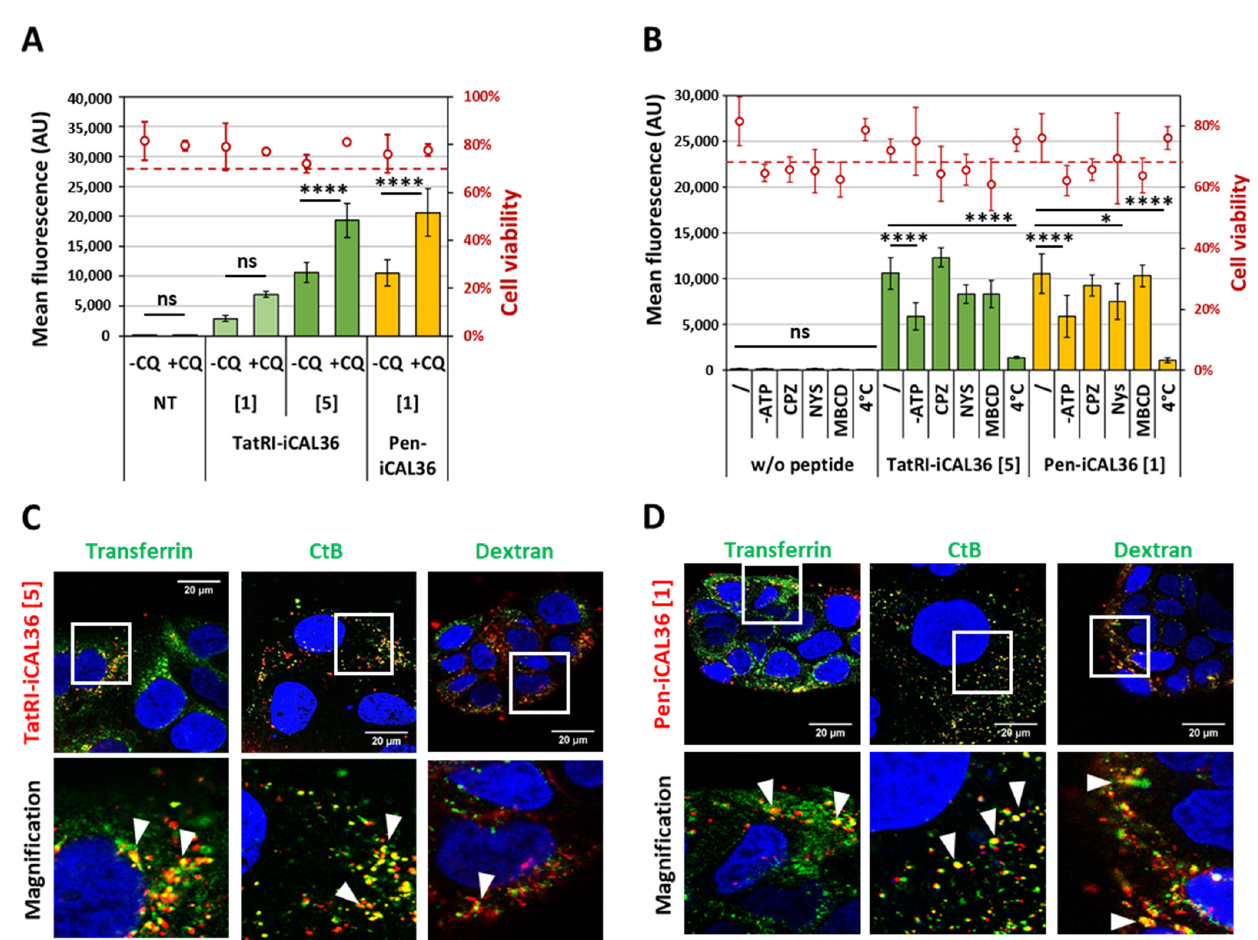
Figure 3. Dissecting the internalization mechanism of TatRI-iCAL36 and Pen-iCAL36. ( A ) Caco-2 cells were incubated with Tamra-TatRI-iCAL36 (1 μ M = [1] or 5 μ M) = [5] and Tamra-Pen-iCAL36 (1 μ M = [1]) and compared to non-treated cells (NT) in the absence or presence of chloroquine (CQ, 100 μ M). After cell trypsinization (to remove external peptides), the fluorescence and cell viability were assessed via flow cytometry. Graphical representation of data obtained from four independent measurements (mean ± SD, n = 4). A statistically significant difference was noticed between the incubation conditions without and with CQ for TatRI-iCAL36 and Pen-iCAL36 at 5 μ M, whereas no statistical difference was revealed for TatRI-iCAL36 at 1 μ M (one-way ANOVA with Bonferroni test, statistical relevance given as **** p < 0.0001 and ns > 0.05). ( B ) Caco-2 cells were incubated with Tamra-TatRI-iCAL36 (5 μ M) and Tamra-Pen-iCAL36 (1 μ M) at 4 °C or in the presence of either ATP- depleting reagents (NaN 3 /DG) or endocytosis inhibitors (CPZ, NYS or MBCD) at 37 °C. The same conditions were used on cells without peptides (w/o peptide) to determine the effect of the endocytosis inhibition. For all conditions, fluorescence and cell viability were acquired via flow cytometry after cell trypsinization (to remove membrane externally bound peptides). Graphical representation of data obtained from four independent measurements (mean ± SD, n = 4). A statistically significant difference compared to untreated condition was noticed for ATP depletion and 4 °C incubation for TatRI-iCAL36 and Pen-iCAL36 (2-way ANOVA with Bonferroni test, statistical relevance given as * p < 0.05, **** p < 0.0001 and ns > 0.05). ( C , D ) Caco-2 cells were incubated with Tamra-TatRI-iCAL36 (5 μ M = [5]) and Tamra-Pen-iCAL36 (1 μ M = [1]) in the presence of endocytosis markers such as transferrin, cholera toxin subunit B (CtB) or Dextran. Next, 10 min before the end of the incubation, Hoechst dye (blue = nuclei) and WGA-Alexa488 (green = cell membrane) were added. Cells were washed and covered with DMEM FluoroBrite before imaging. White bars represent 20 μ m.